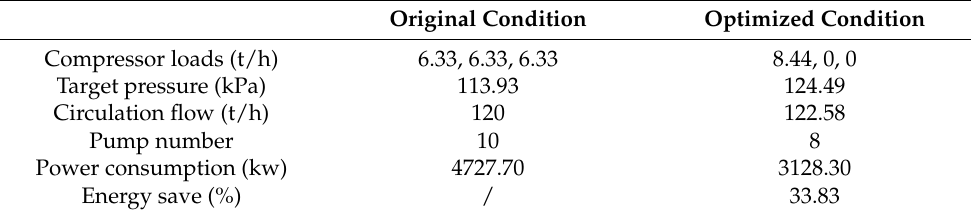
Figure 6. Optimized operation condition of the proposed method. Table 10. Energy consumption